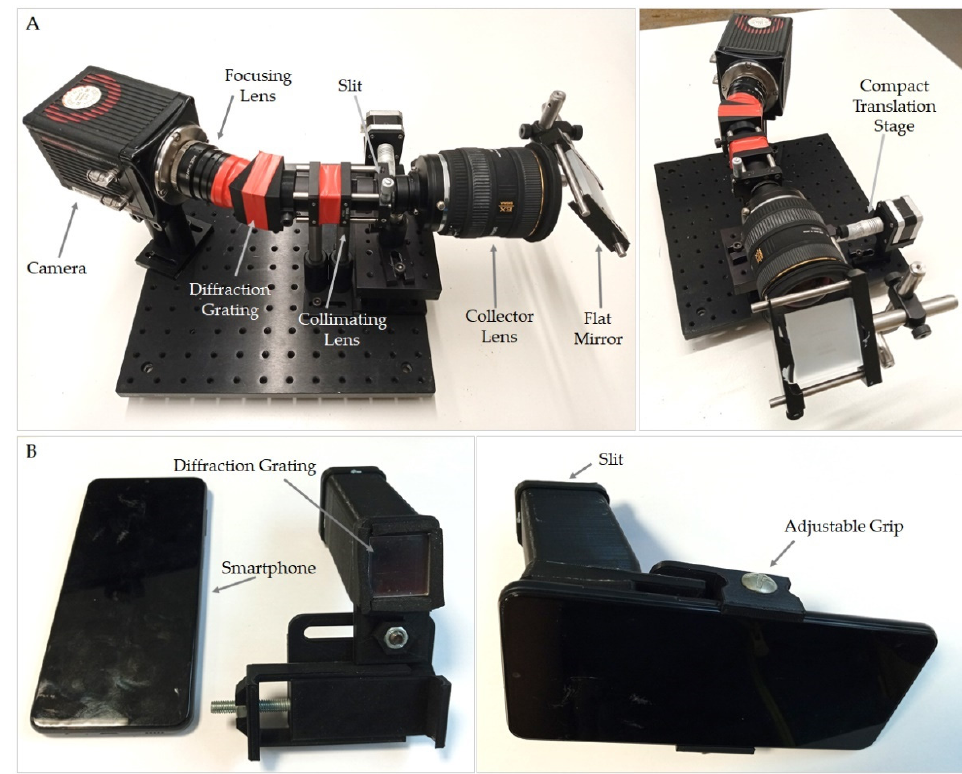
Figure 1. Low-cost hyperspectral imaging instrumentation utilised within this research. ( A ) shows the semi-portable Low-Cost High-Resolution instrument. ( B ) shows the ultra-low-cost Hyperspectral Smartphone instrument both before connection with a smartphone (left) and after connection and alignment of the spectral components with the built-in smartphone camera